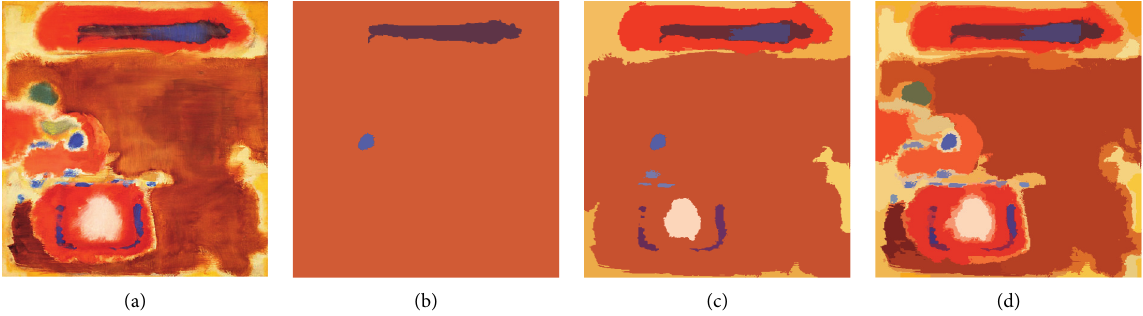
Figure 1: Mark Rothko: Untitled (1947). From left to right: original image, 3, 13, and 60.